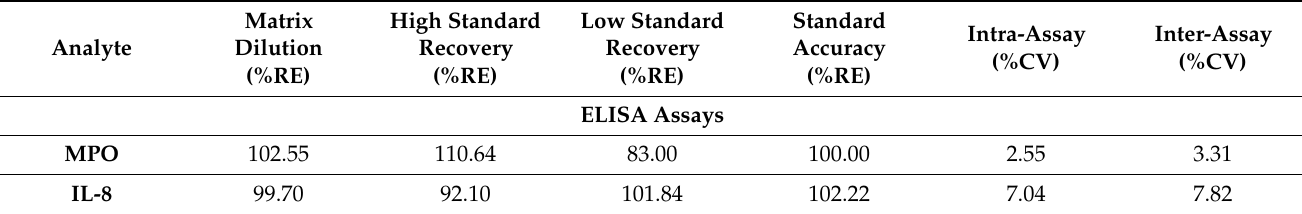
Table 1. Method Development and Validation